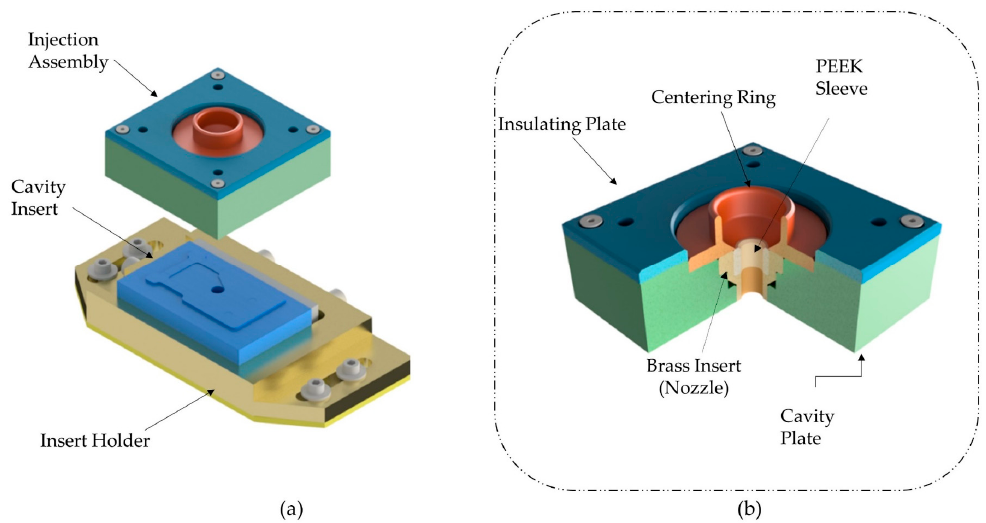
Figure 7. Mold assembly: ( a ) Main parts of the assembly; ( b ) an injection assembly unit. Adapted from Heredia et al. [20].